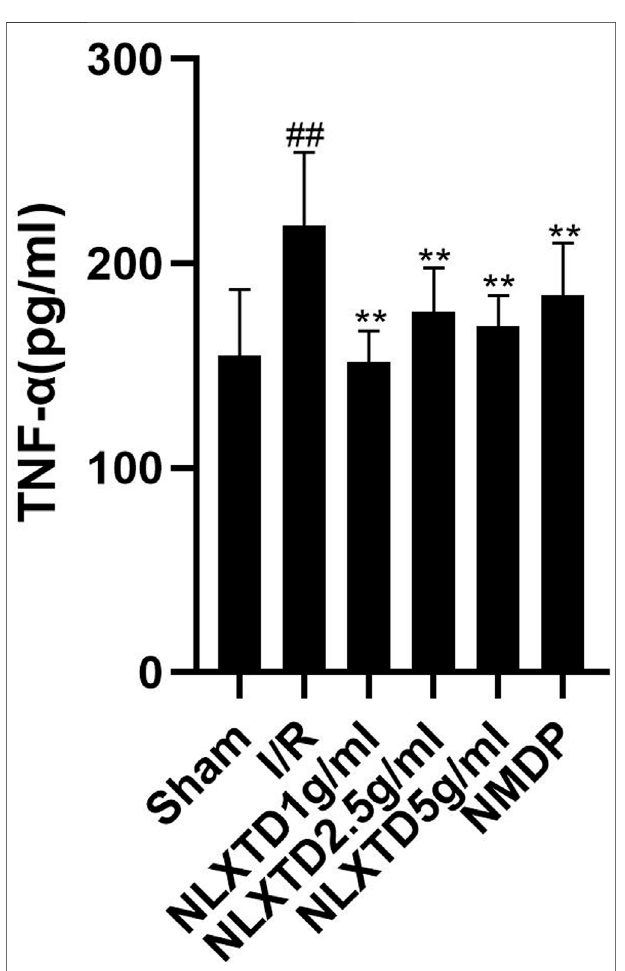
Frontiers in Pharmacology |